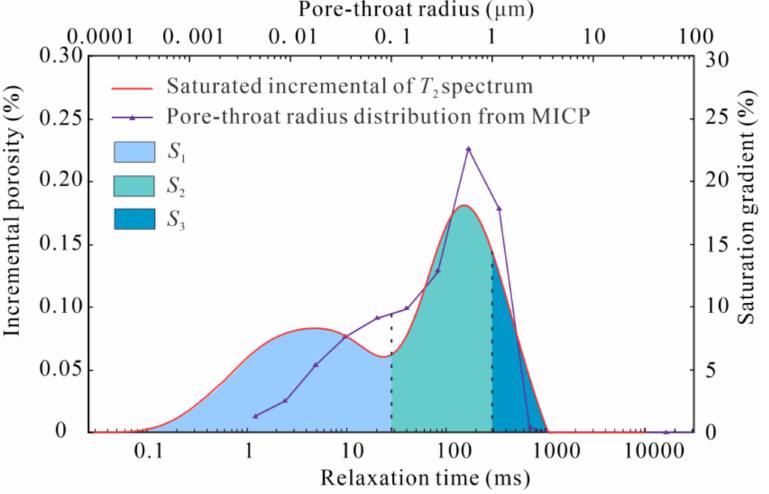
Figure A3. Pore throat sizes and pore components derived from NMR and MICP